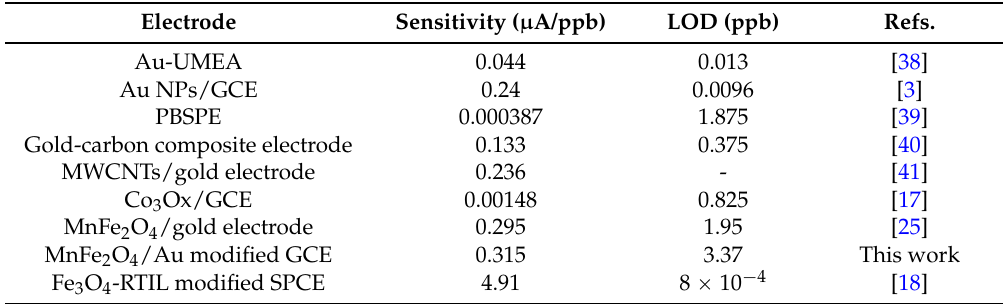
Gold-carbon composite electrode Co 3